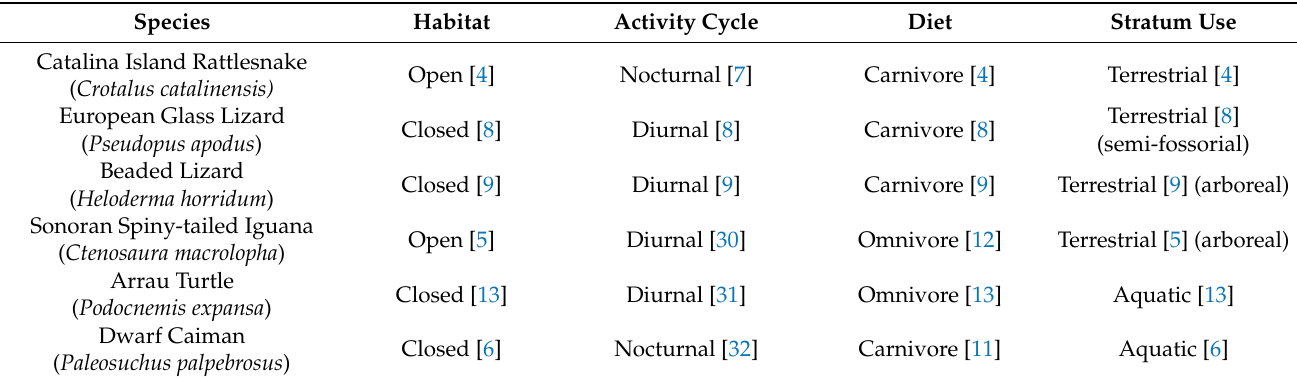
Table 1. Summary of natural ecology factors for each